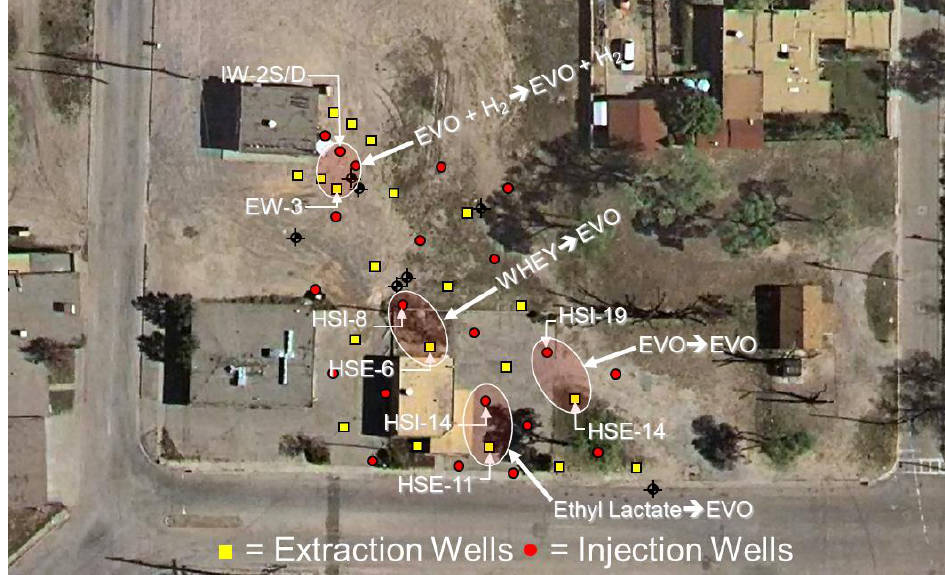
Figure 2. Pilot test cell well pairs. The substrate formulations added to each test cell at the beginning and midpoint of the pilot testing are shown.